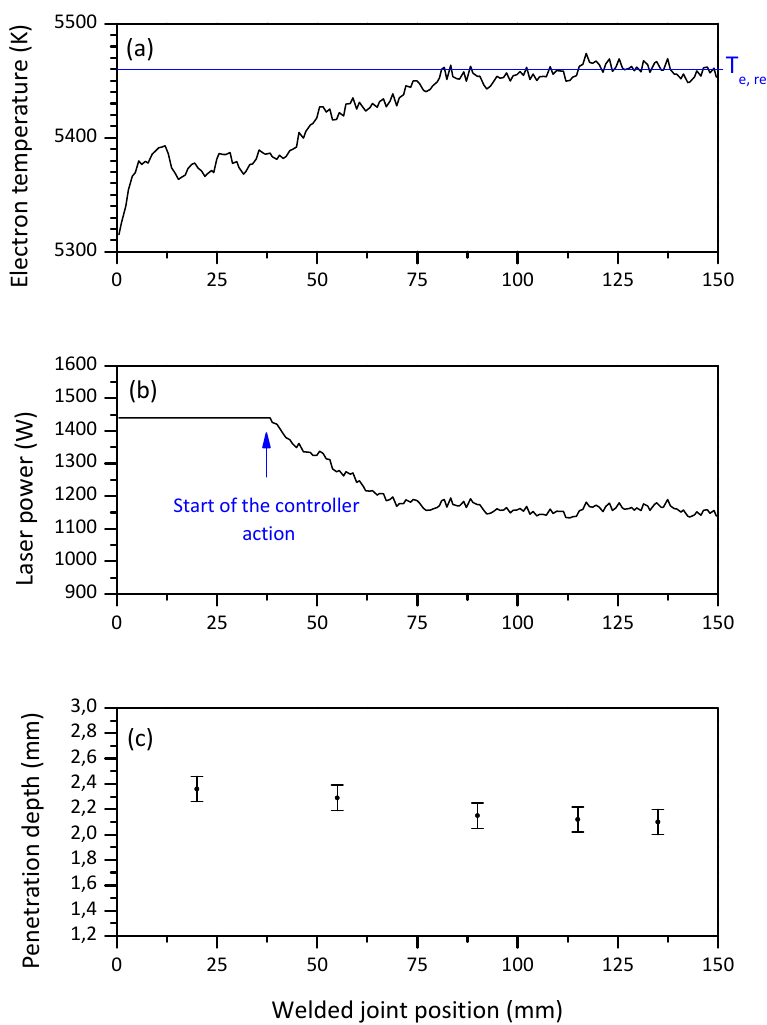
Figure 6. ( a ) Electron temperature signal behavior. Controller parameters: T corresponding to a penetration depth of 2 mm; K power = 1,440 W. ( b ) Laser power measured by fast power sensor. ( c ) Penetration depth